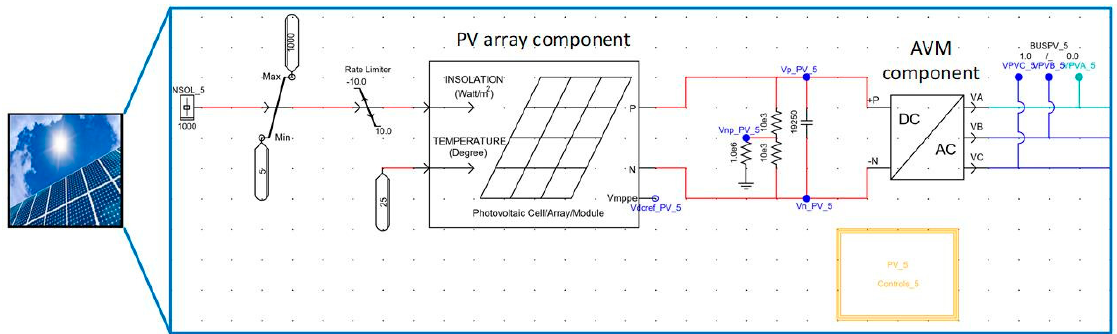
Figure 6. Components for solar PV system used in the variation model.